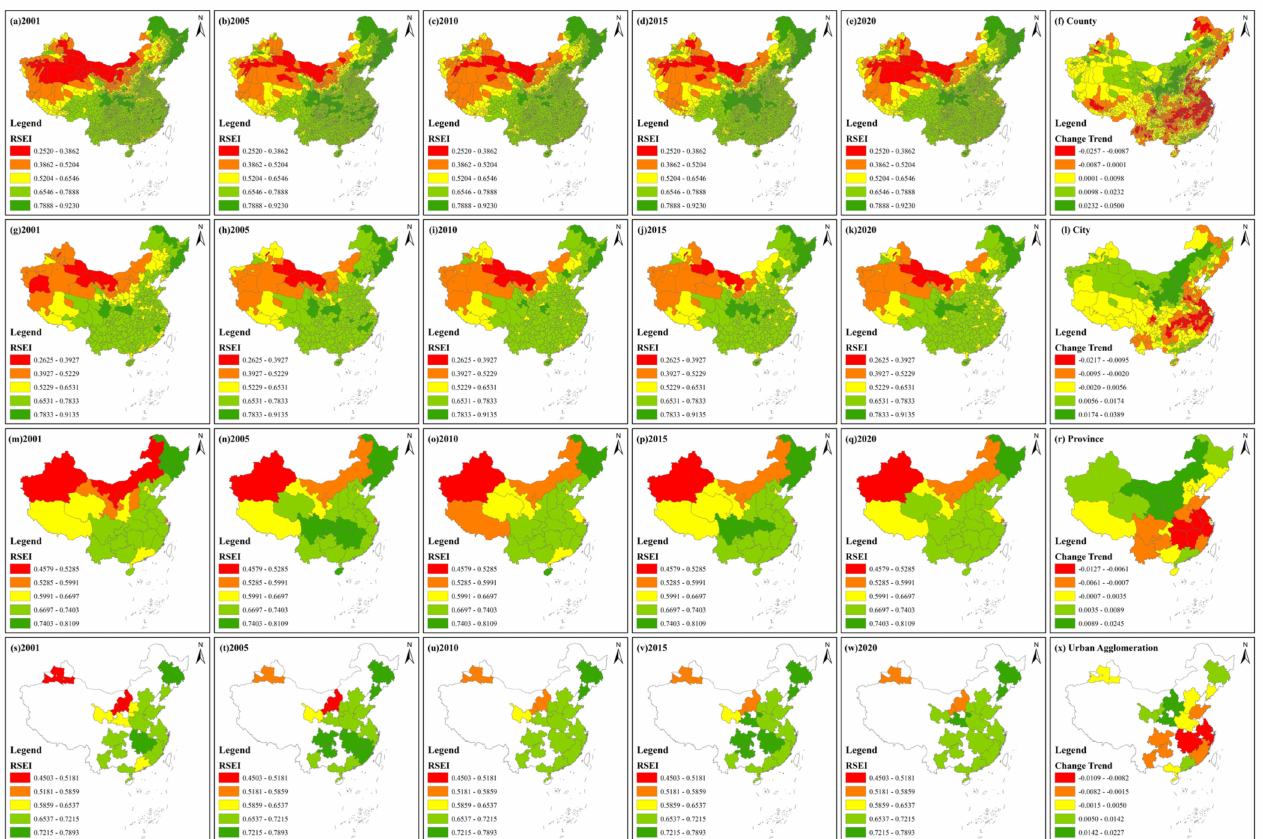
Figure 3. Spatial distribution and change trend of the RSEI from 2001 to 2020 at different